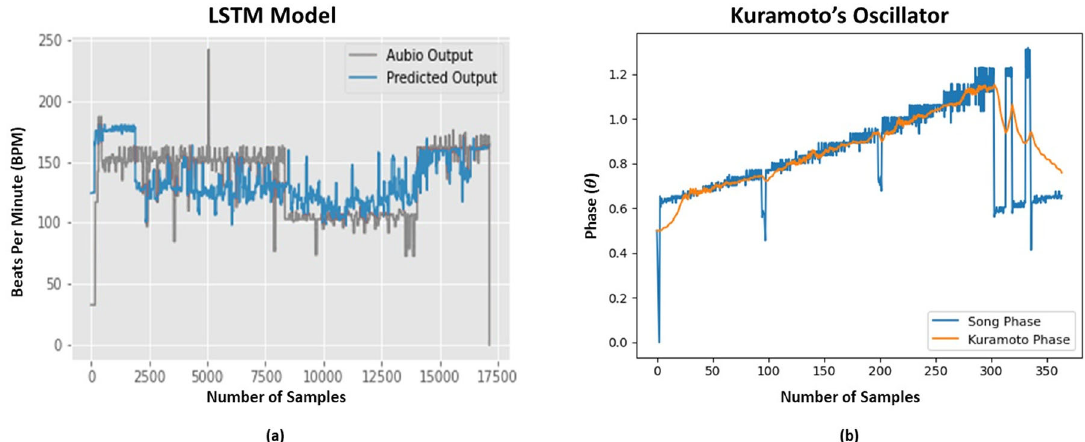
Fig. 3 Beat detection and phase synchronization for single instrumental piece. a Accurate Beat Detection by predictive LSTM model on an input audio stream. The model is seen to closely follow the Aubio ’ s (Brossier, 2006) output obtained. b Phase Synchronization achieved between an audio stream and Kuramoto Oscillator (Blue line shows the output phase from Aubio and orange line denotes the Kuramoto ’ s phase). The LSTM model was trained and tested to follow the tempo of the dominant instrument in terms of beat per minute (BPM) on the MUSDB18 STEM dataset (obtained from sigsep.github.io/datasets/ musdb.html#musdb18-compressed-stems). The dataset consists of 150 full songs encoded at 44.1kHz, and ~10h duration of different genres with their isolated drum, vocal, bass and other stem. In this experiment, the pitch, tempo and volume features were extracted from each stem in real-time. A LSTM model was created to predicit and follow the tempo of the dominant instrument which was guiding the rhythm of the full mix. The Kuramoto ’ s Oscillator was explored to see how multiple instruments can achieve synchronization. As input to the model, we used a a drum beat with varying tempo between the ranges of 85 BPM to 170 BPM with a increase by 5 units at every 64 beats (obtained from www.youtube.com/watch?v = LVJ32rQXDbw&t = 8s&ab_channel = MessiahofFire), and as detected by the Aubio Python library. The Kuramoto ’ s Oscillator was allowed to synchronize with the drum